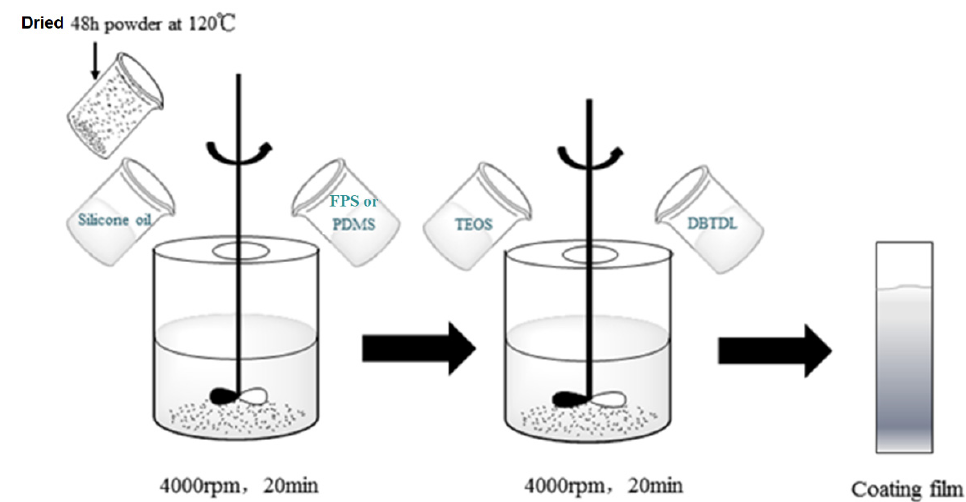
Figure 1. Schematic diagram of preparation process for studied coatings.